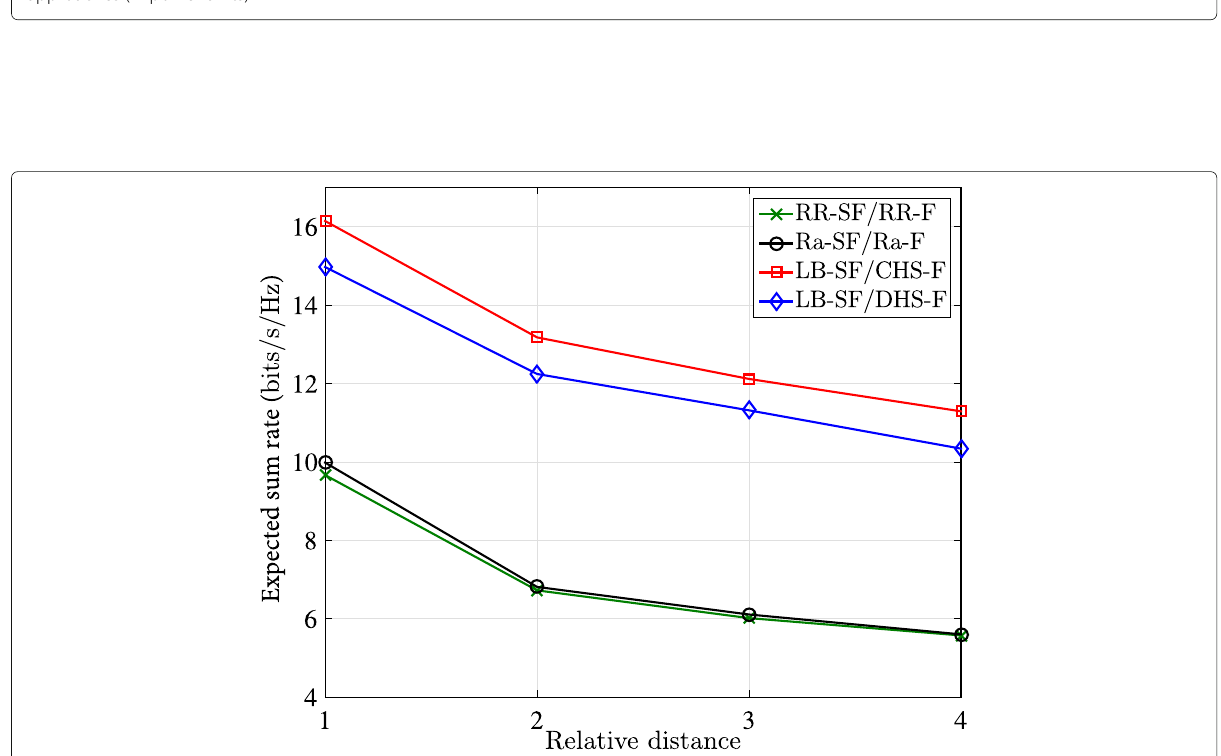
Fig. 8 Expected system sum rate vs distance to the BS. Expected system sum rate as a function of the distance to the